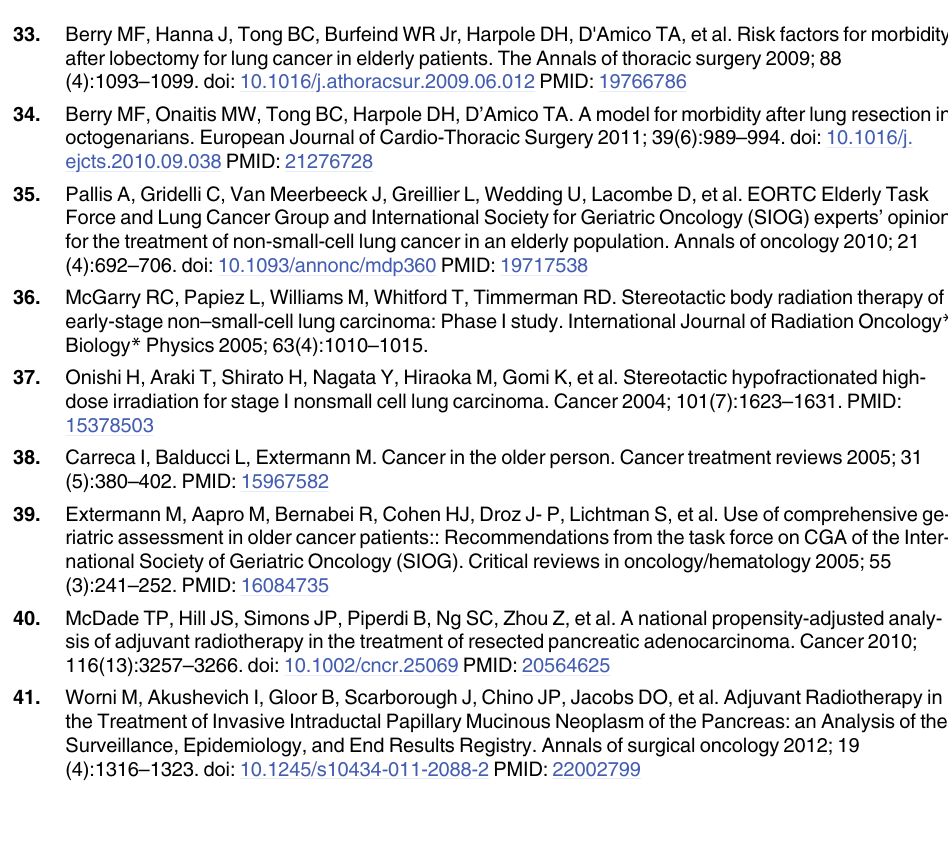
PLOS ONE | DOI:10.1371/journal.pone.0121406 April 7,